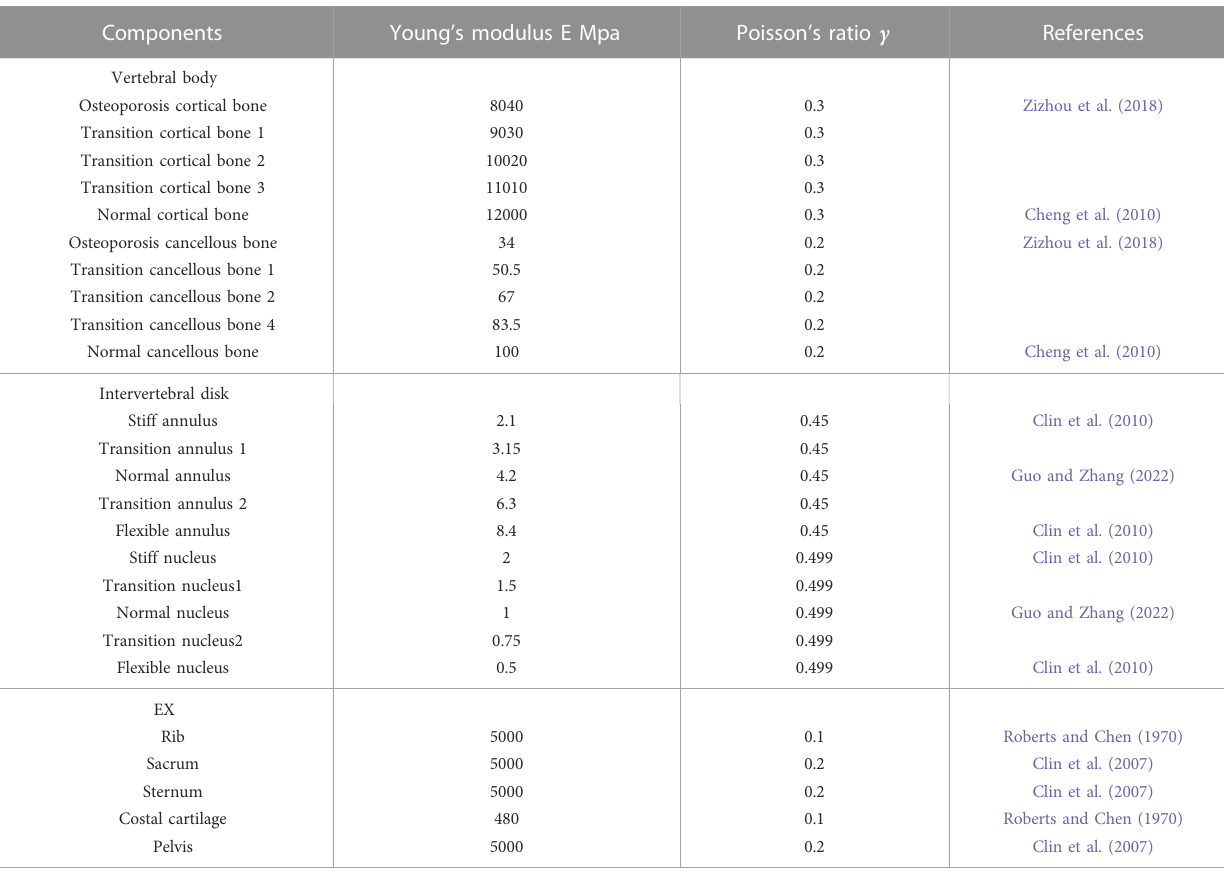
TABLE 1 Material properties of each component.